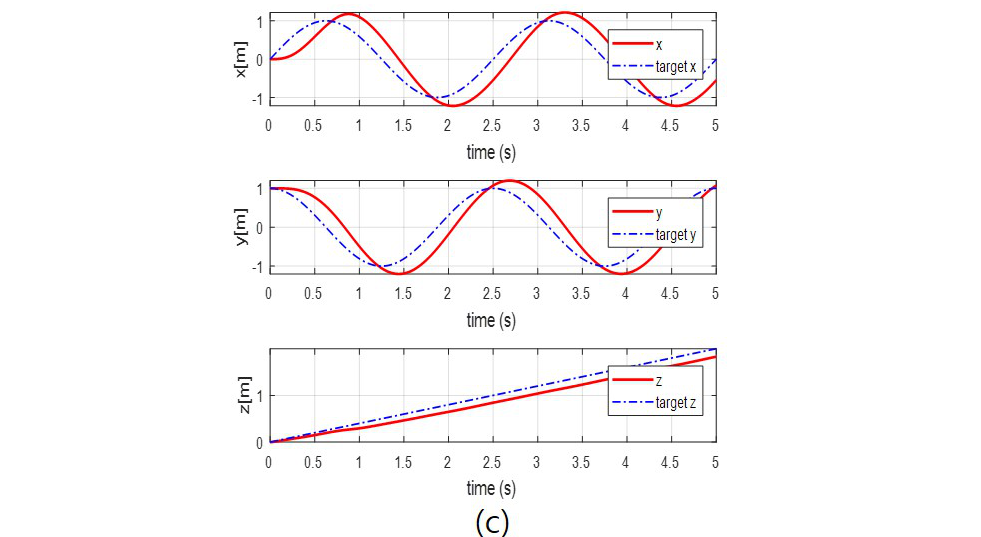
Figure 12. Circular trajectory tracking control results for each of the three axes: ( a ) Inverse optimal control; ( b ) LQR control; ( c ) PD control.